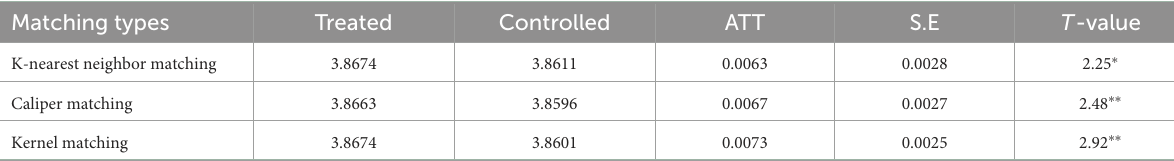
TABLE 5 PSM results for the effect of equalization of public health services on the health of the migrant population. Matching